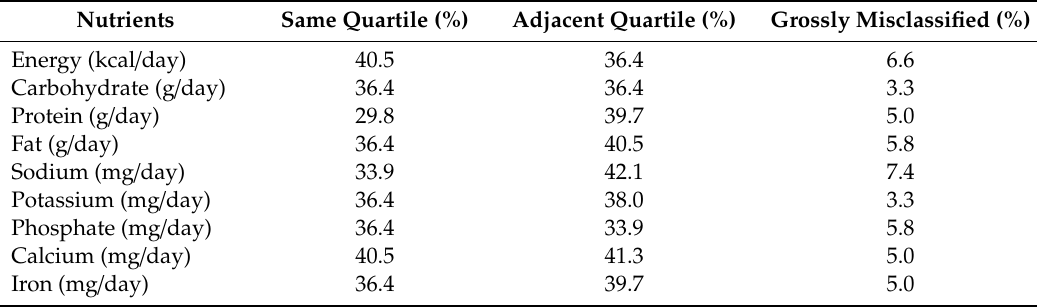
Table 6. Cross-quartile classification of nutrients derived by HD-FFQ and 3DDR methods. Nutrients Same Quartile (%) Adjacent Quartile